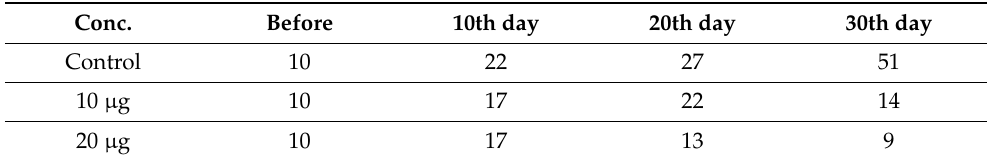
Table 2. Total count of earthworms exposed to silver nanoparticles synthesized using Bauhinia purpurea gum.